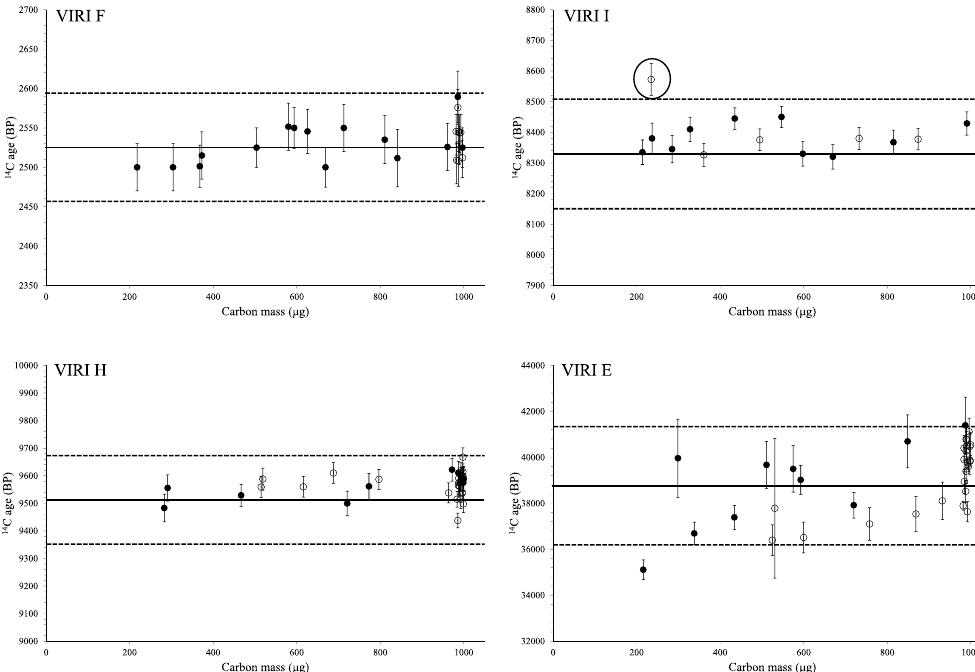
Figure 2. Relationship between the carbon mass of the graphite target and the measured radiocarbon age of the VIRI samples. Solid lines correspond to the average consensus AMS age for each VIRI sample. Dotted lines indicates the upper and lower limit of consensus AMS ages (one sigma, as stated in ref. 48). Open and closed circles are for large ( > 100 mg) and small ( < 100 mg) bone samples, respectively. The one encircled VIRI